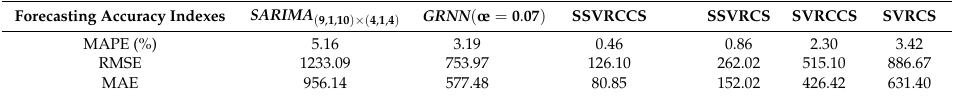
Table 7. Forecasting accuracy indexes of compared models for Example